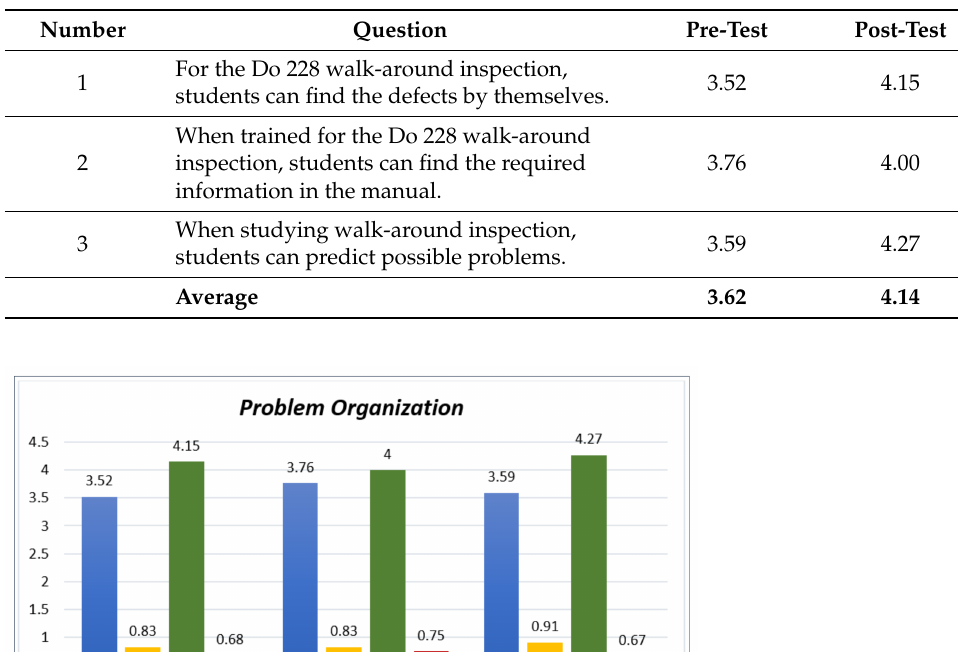
Table 3. Results for the problem organization.